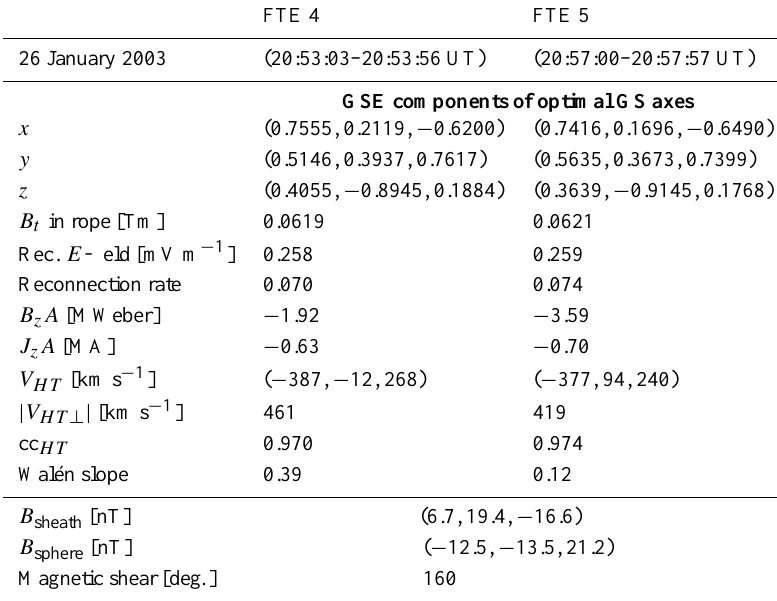
Table 2. Parameters for reconstructed FTEs seen by Cluster on 26 January